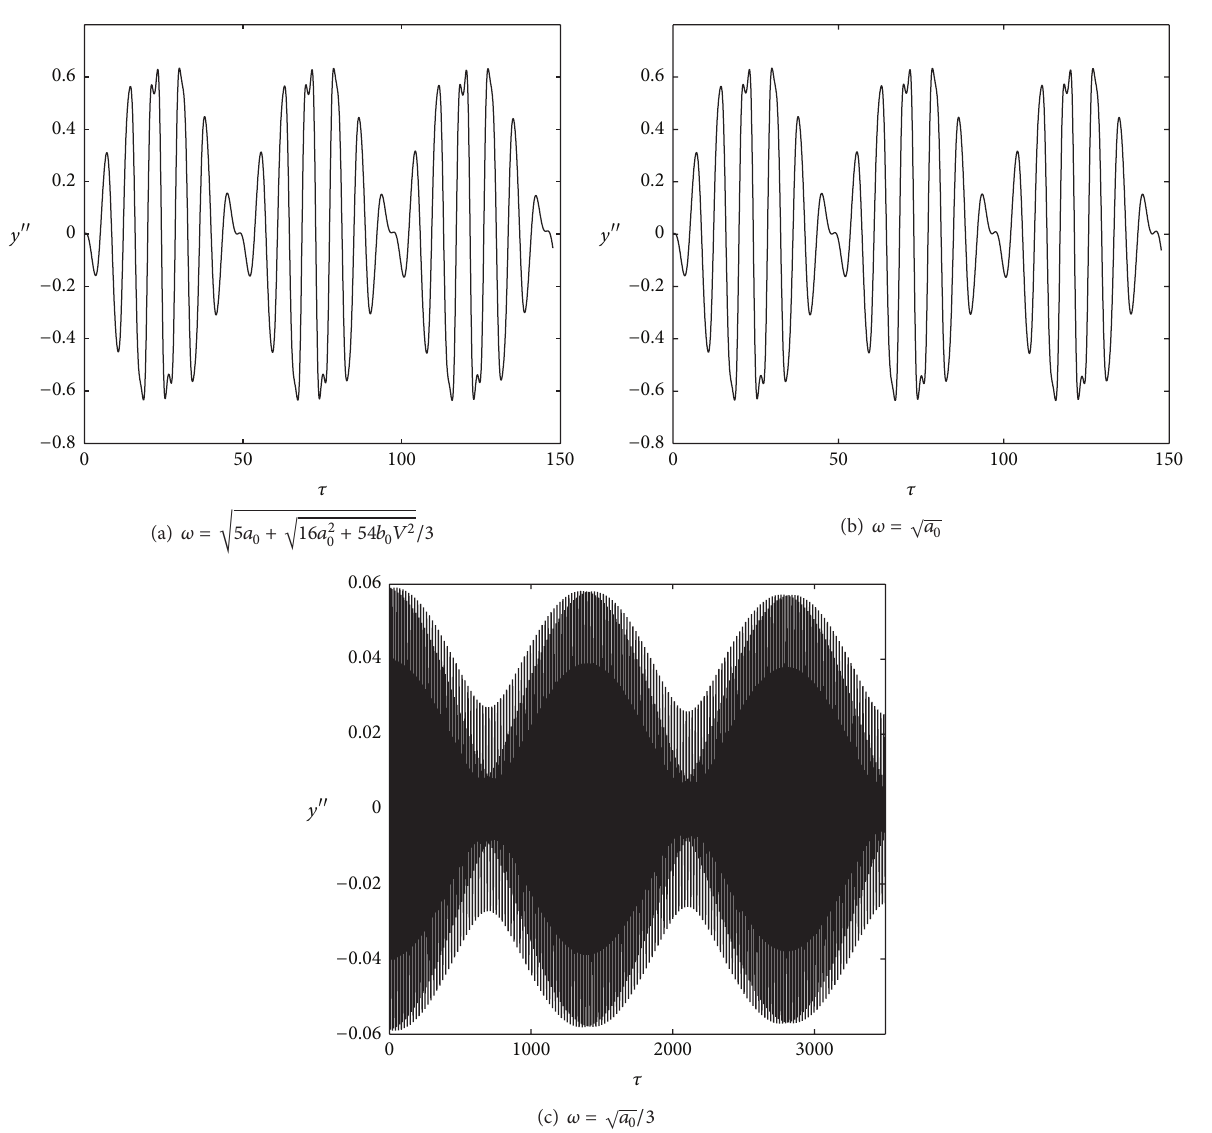
Figure 6: The nondimensional acceleration response of the system under conditions for resonance.